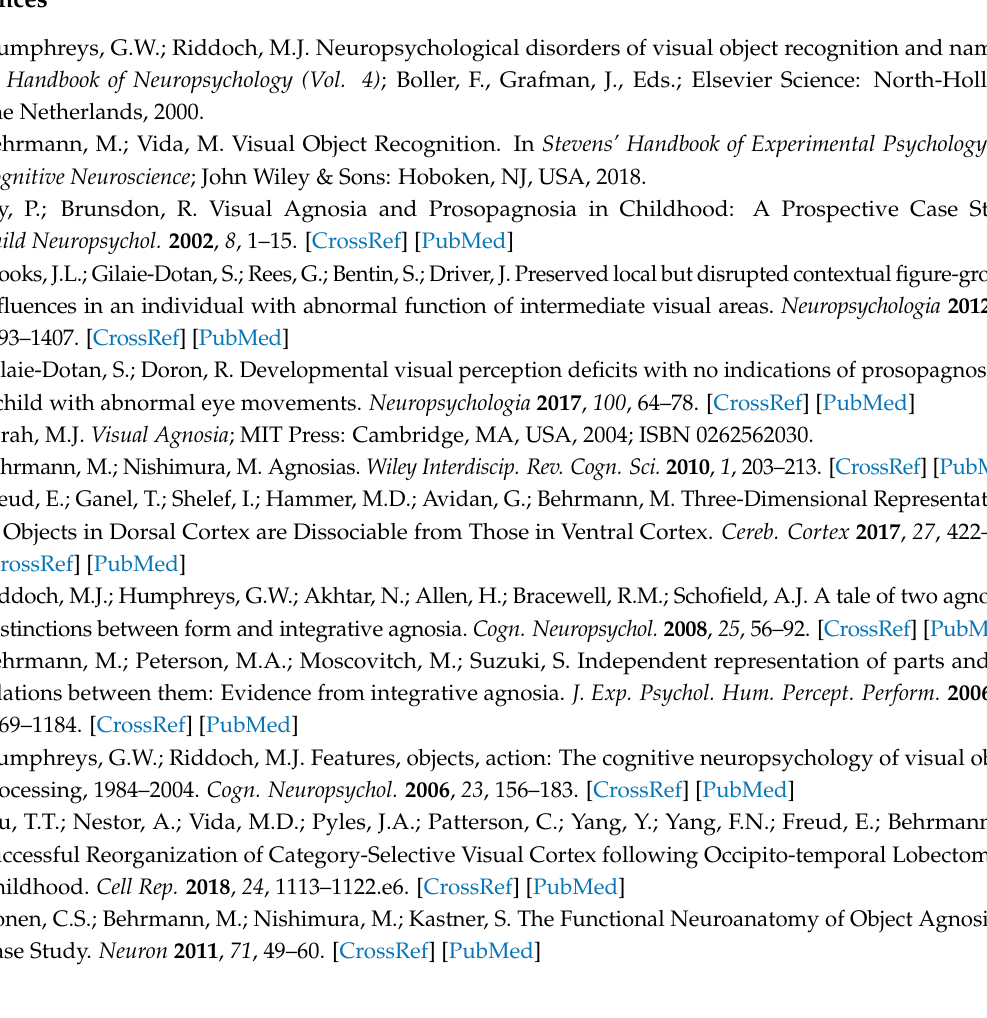
Figure S1: Event-related potentials, Figure S2: Decoding results by visual field, Figure S3: